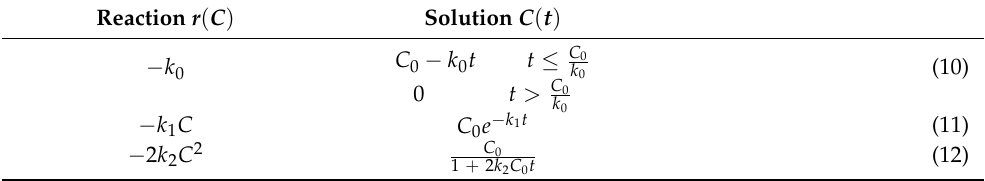
Table 1. Solutions for the concentration C ( t ) in the batch reactor for the different reaction orders. Reaction r ( C